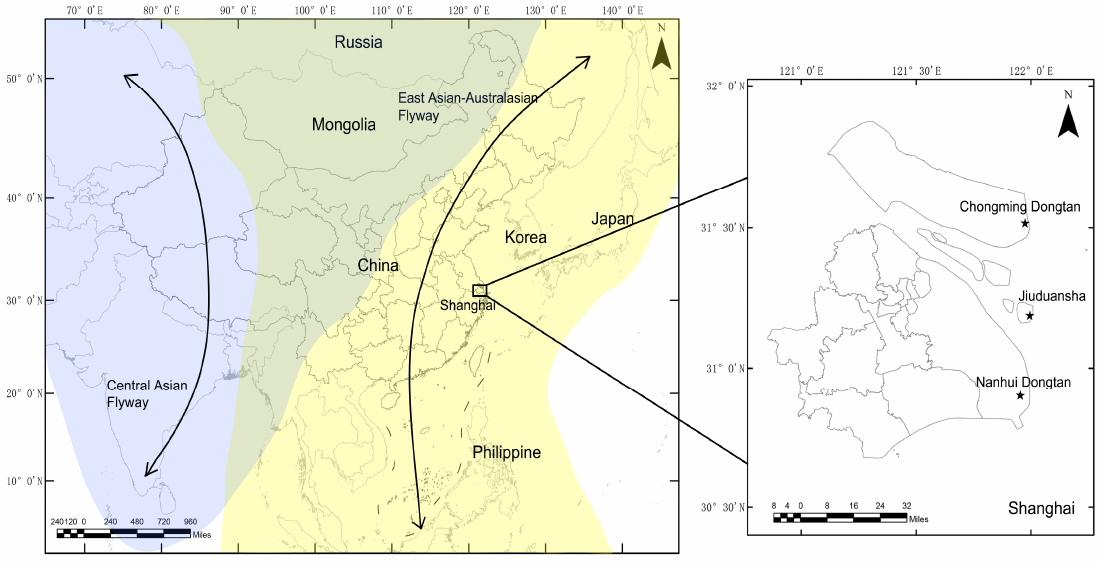
Figure 1. Locations of sampling sites at which the wild birds were monitored in Shanghai, 2016–2018. Shanghai is located in the East Asian–Australasian migratory wild bird flyway, which is marked with a yellow background. The locations of sampling sites are displayed using stars.